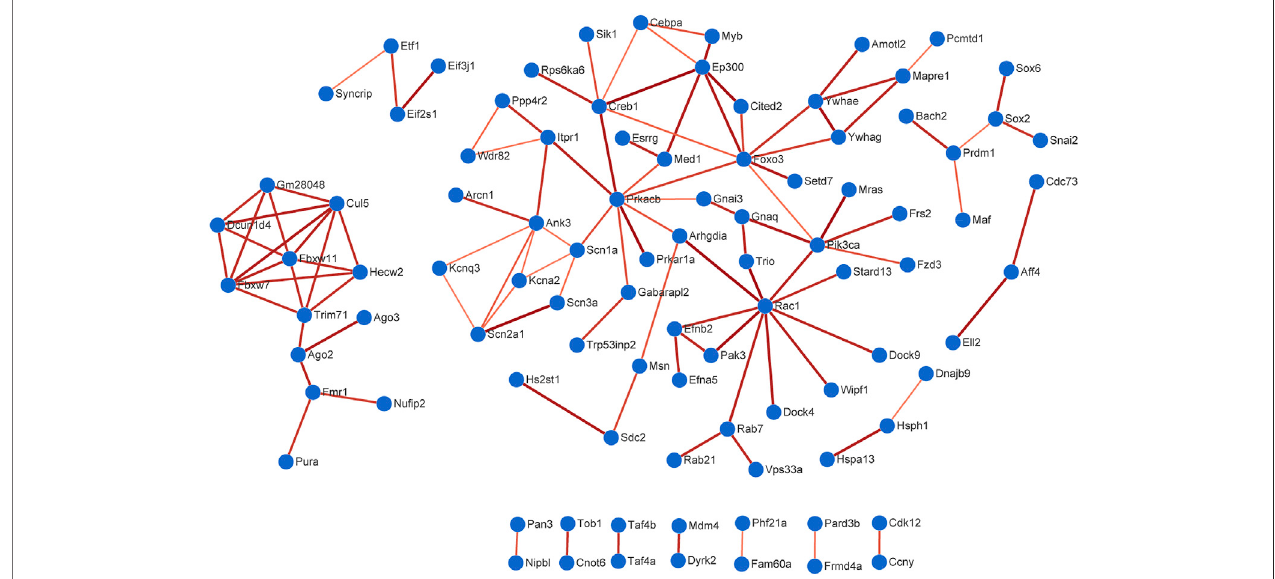
FIGURE 6 | Protein-protein interaction (PPI) analysis. A total of 94 genes exhibited interactions in 225 overlapping target genes of miR-200b-3p and miR-182. Large sizes and dark colors of edges meant high value of combined scores. High con fi dence score of 0.7 was selected to construction PPI network.